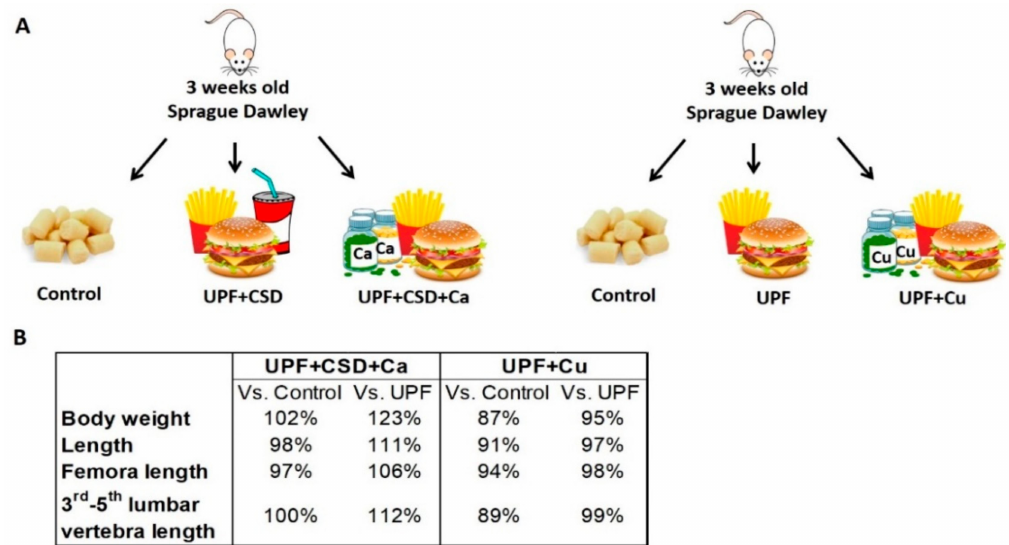
Figure 4. Supplementation of ultra-processed diet with calcium (Ca) prevents damage to growth, whereas supplementation with copper (Cu) does not prevent damage. ( A ) Schematic illustration of the experimental setup. ( B ) The physiological parameters (body weight, length, femora and third to fifth lumbar vertebra length) of the supplemented groups compared with Control or the UPF based